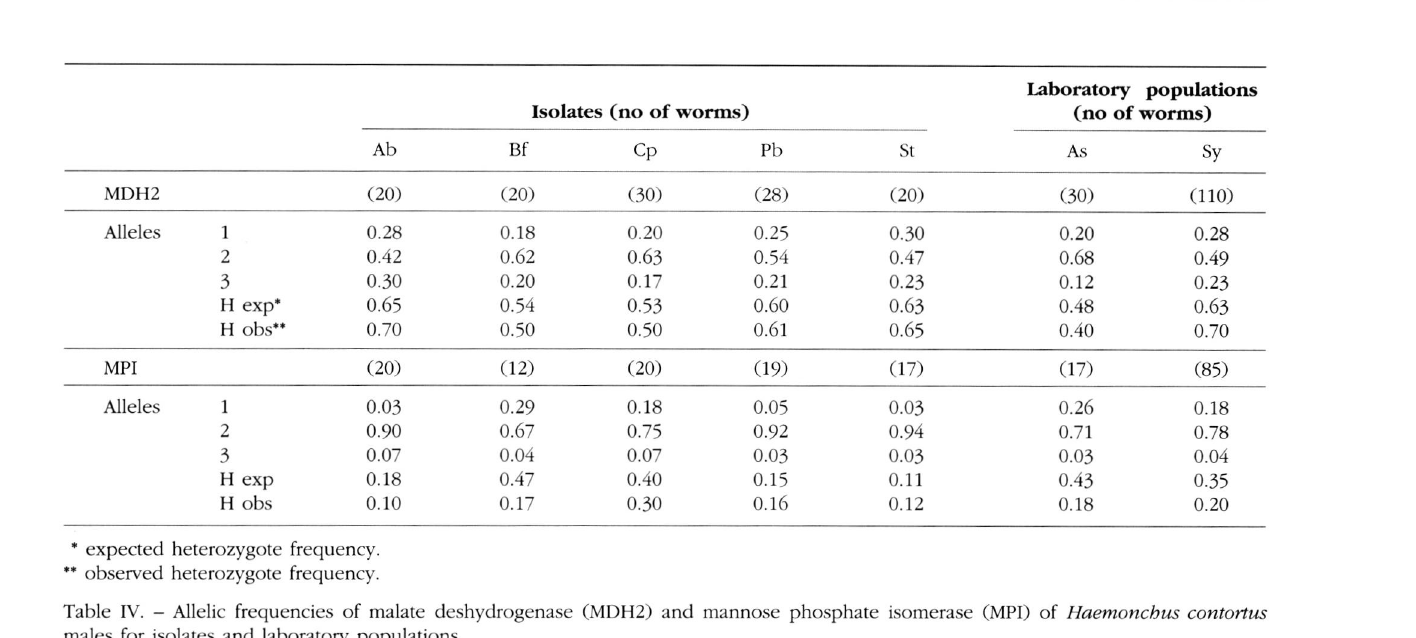
Table IV. - Allelic frequencies of malate deshydrogenase (MDH2) and mannose phosphate isomerase (MPI) of Haemonchus contortus males for isolates and laboratory populations.